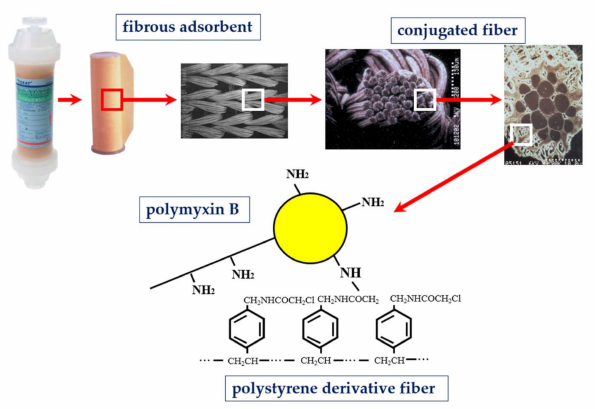
Figure 1. Structure of polymyxin B immobilized fiber column.